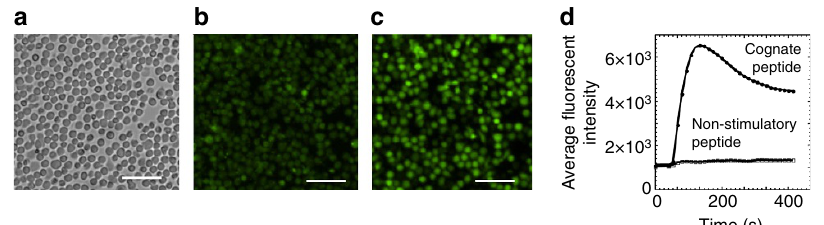
Figure 2 | Detection of responding Tcells in the monolayer. Cloned CD8 þ Tcells CER43 labelled with Fluo-4 were attached to a glass bottom of 96-well plates covered with poly-L-lysine via non-blocking anti-LFA-1 antibodies to form a monolayer ensuring direct contact of T cells with each other ( a , b ). Addition of a strong agonist peptide GILGFVFTL (GL9) to the monolayer of the labelled T cells induced intracellular Ca 2 þ flux resulting in the time- dependent increase of intracellular fluorescence intensity that reaches maximum in 2–3min ( c , d ). Addition of non-stimulatory peptide ILKEPVHGV (IV9) did not lead to the increased of intracellular fluorescence ( d ). Data are representative of nine independent experiments. Images ( b ) and ( c ) are taken at time 0 and 220s after the stimulation, respectively. The results shown on d are based on the analysis of 4,500 T cells. Scale bars, 50 m m.